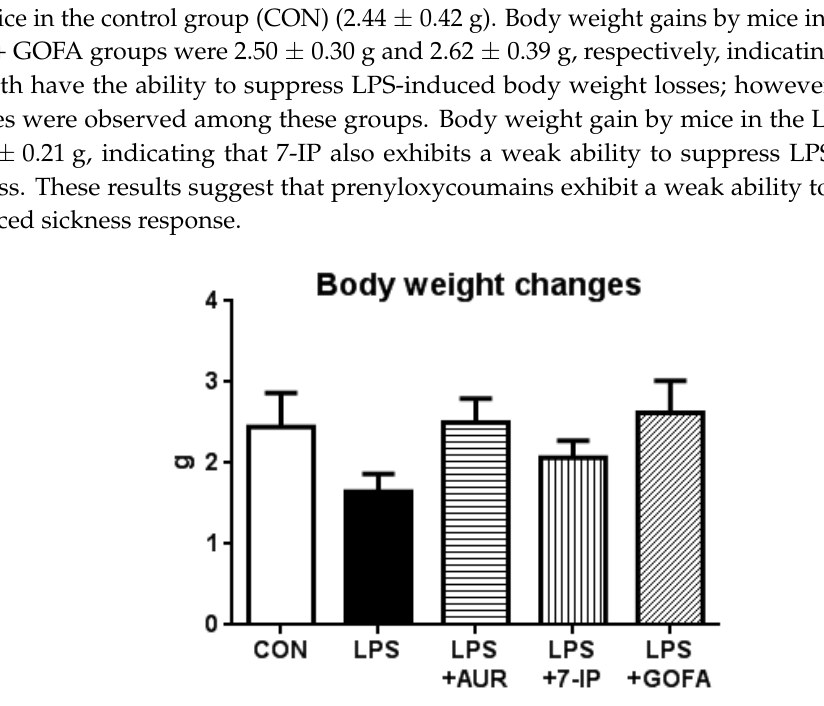
Figure 2. Effects of AUR, 7-IP, and GOFA on lipopolysaccharide (LPS)-induced body weight loss. The control group was defined as CON. Values (means ± SEM) are changes in body weight from day 1 to that on day 22.